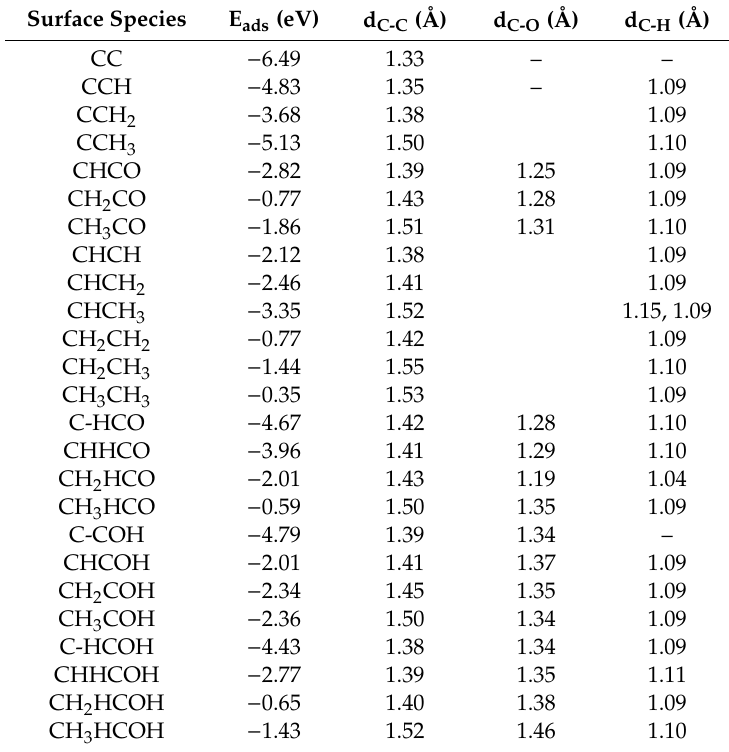
Table 1. Adsorption energies and structure parameters of C 2